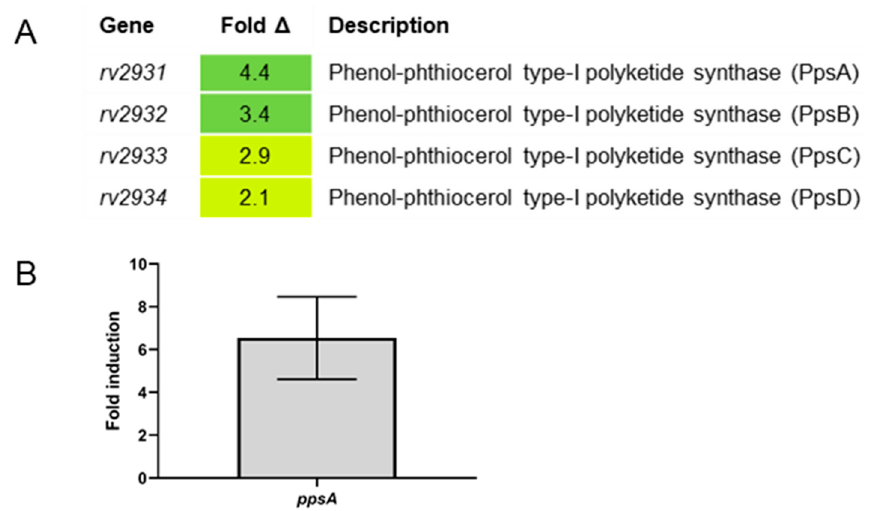
Figure 5. ( A , B ). Genes differentially expressed >2-fold in Erdman vs. ∆ sigC cultured in copper-supplemented SMT medium. ( A ) Microarray studies were performed to examine global expression differences between strains Erdman and ∆ sigC cultured to OD 600 = 1 in SMT supplemented with 6 µ M CuSO 4 . Microarrays used contained probes to the OFSs from M. tuberculosis strain H37Rv. Only genes with significant differential expression after SAM analysis of more than 2-fold are shown. ( B ) Expression of rv2931 ( ppsA ) from strains cultured similarly was examined by qRT-PCR normalizing to sigA . Mean and standard error of 3 biological replicates is shown.